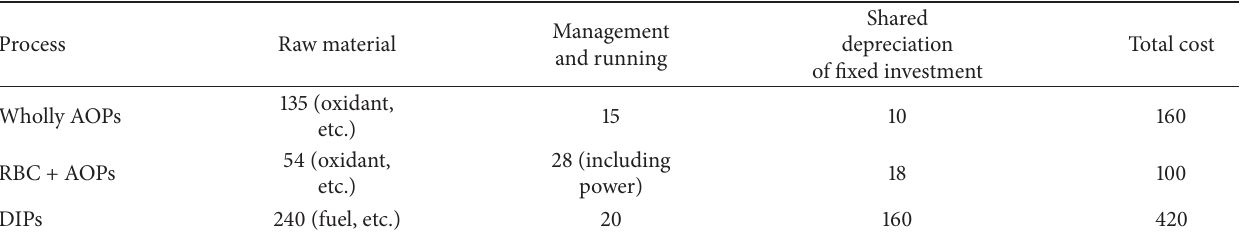
Process Wholly AOPs RBC + AOPs DIPs 240 (fuel,